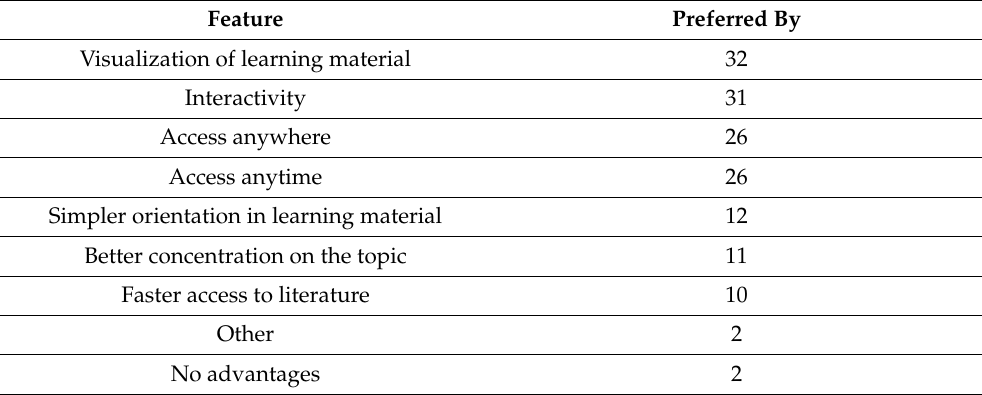
Table 5. Preferred VRE features.